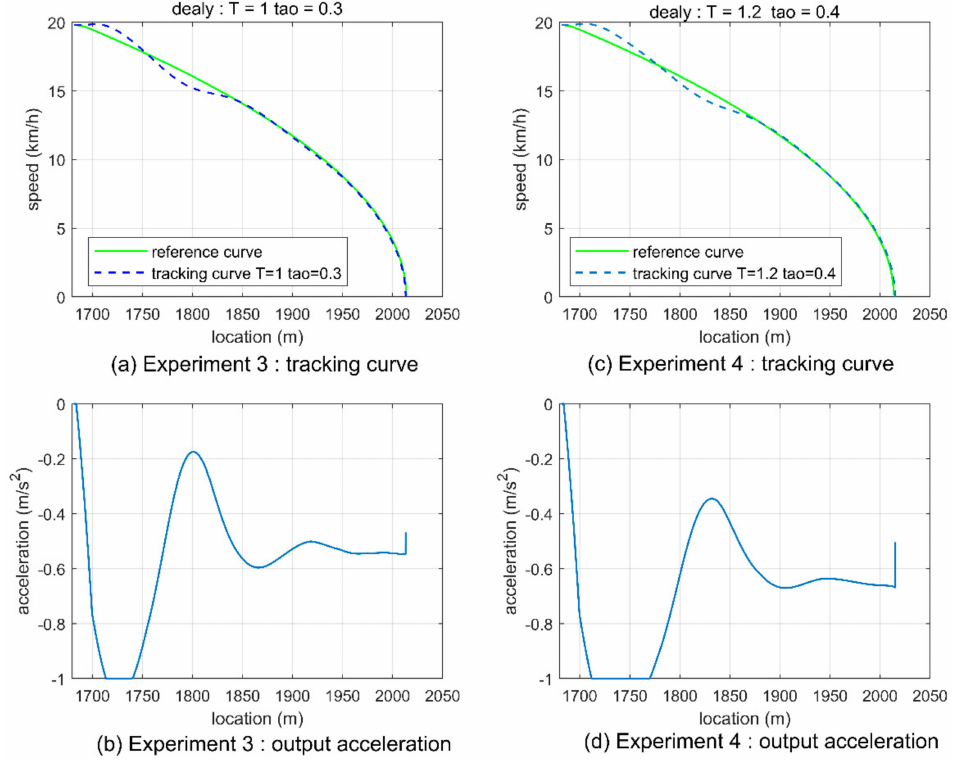
Figure 20. Comparison of PID and ATSMC + DOB: ( a ) Comparison in tracking curve; ( b ) Comparison in speed